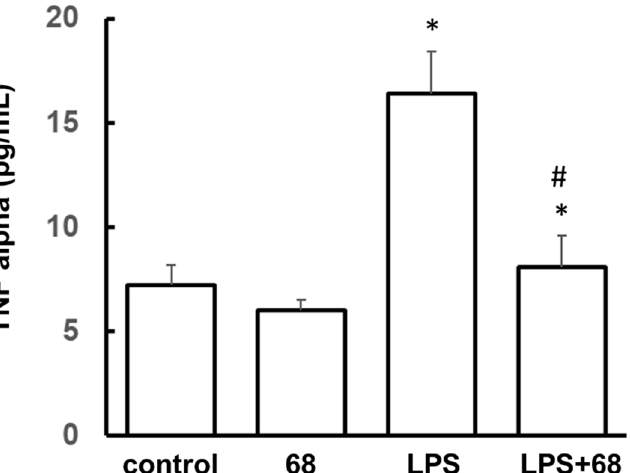
Figure 3. Compound 68 reduced LPS-induced TNF- α secretion. Human lymphoblasts were